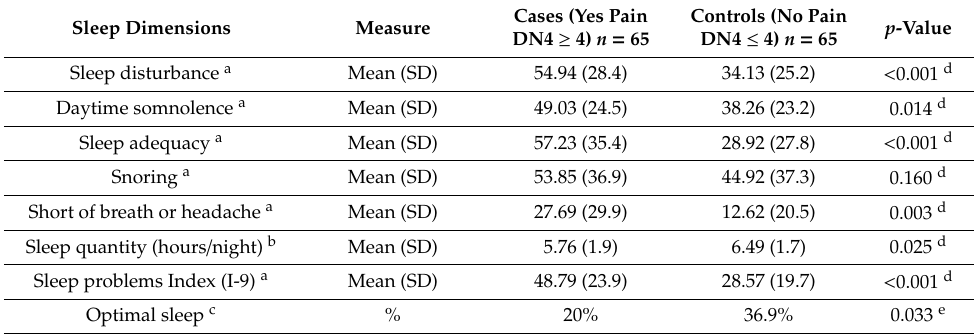
Table 2. Medical Outcomes Study (MOS) sleep dimensions scores in DNP patients and no DNP